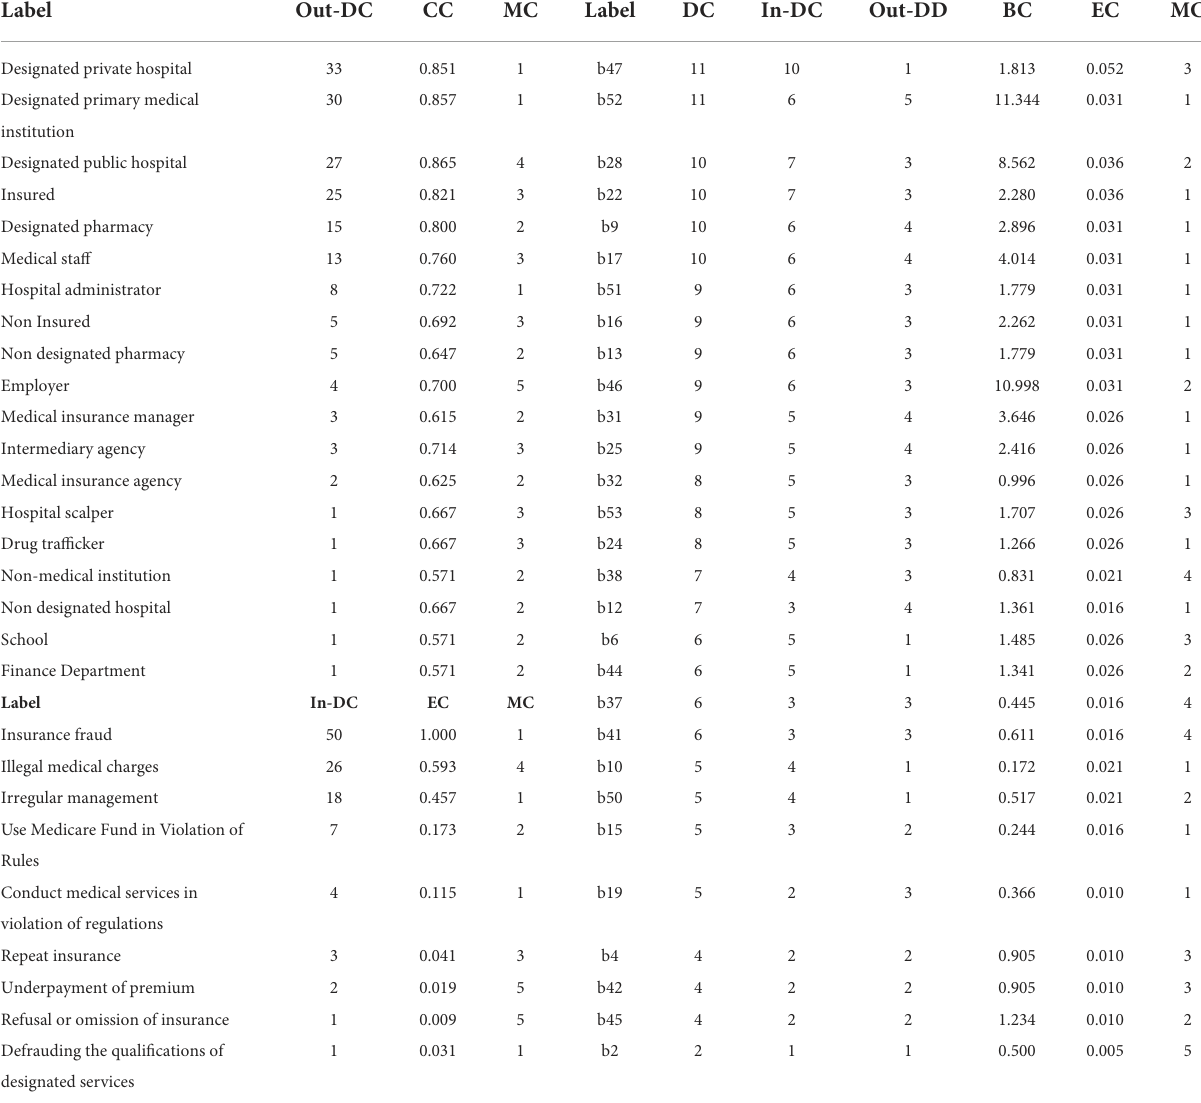
TABLE 3 Social network metrics of the subject–behavior problem of moral hazard in medical insurance